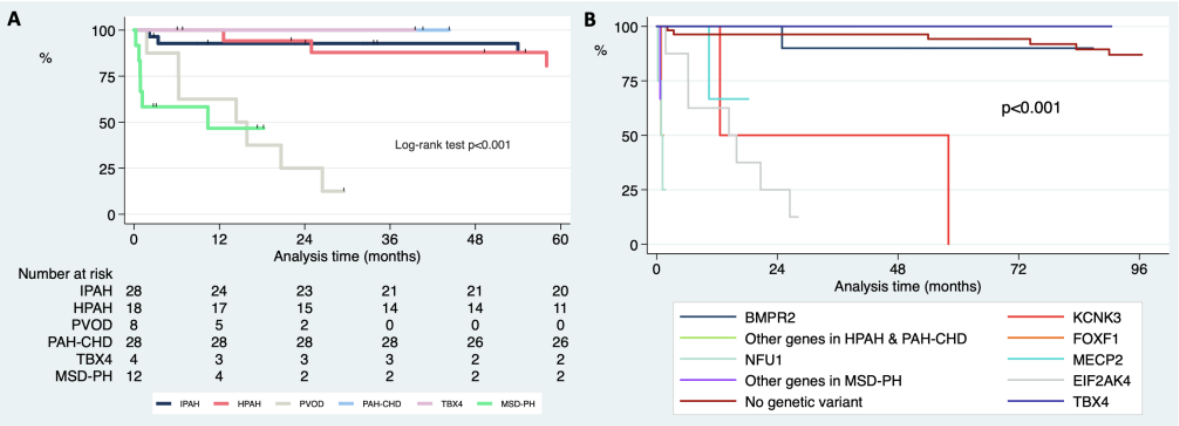
Figure 4. Kaplan–Meier curves of free survival of death or lung transplantation comparing the different types of pediatric PAH after genetic testing (A) and comparing exclusively the specific genetic background (B). DLD (development lung disorders), PAH (pulmonary arterial hyperten- sion); PAH-CHD (pulmonary arterial hypertension associated with congenital heart disease); PVOD (pulmonary veno-occlusive disease).